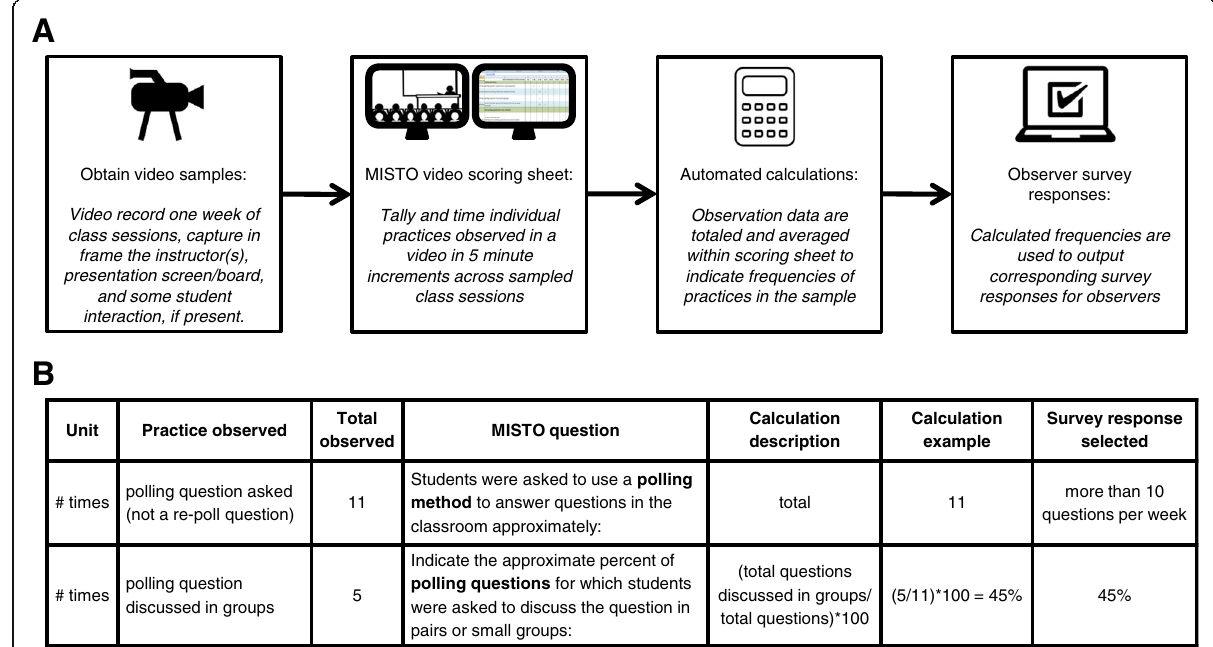
Fig. 1 MISTO video observation process. a Diagrammatic representation of the observer scoring process. Observers score videos from class sessions using MISTO video scoring sheets. Embedded formulas in the workbook calculate observer survey responses and scores. b Hypothetical example of how teaching practices in a video sample are converted to observer survey responses. Here, polling questions are totaled and used to answer the corresponding survey question resulting in a survey response of “ 10 or more questions per week. ” The number of polling questions discussed in groups is totaled and then used to calculate the percent of polling questions discussed in groups, which results in an observer survey response of 45%